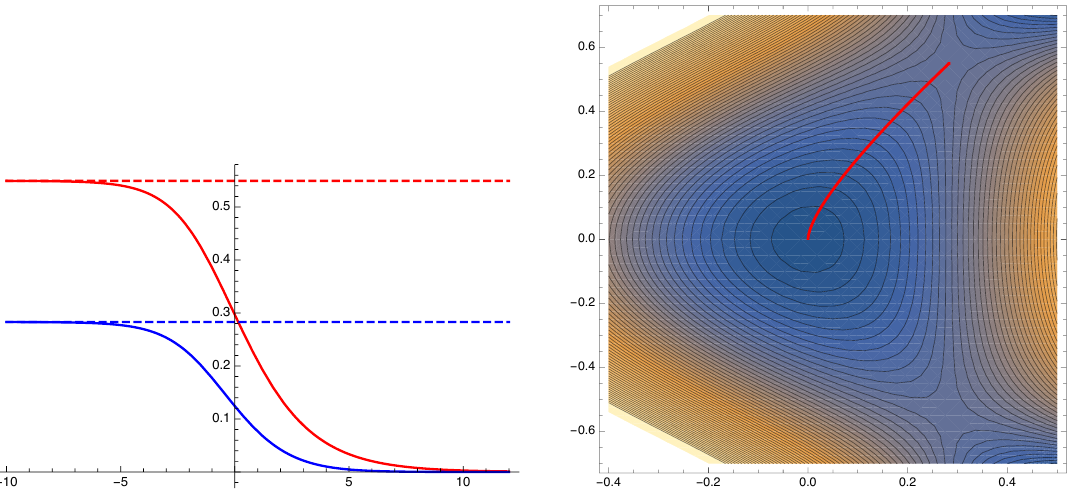
p 6 log (cid:6)( r ) (blue solid line). The p 6 log (cid:6) = 0 there. We have (cid:12)xed g = 1 and p 6 log (cid:6) (horizontal